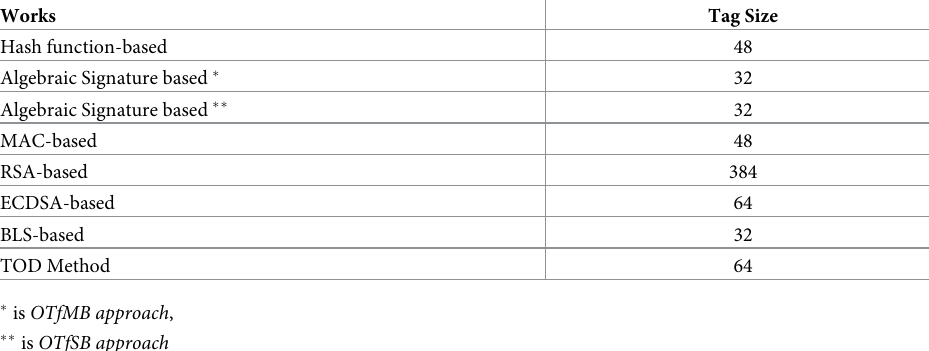
Table 12. TOD method vs the related work: The tag size generated (in